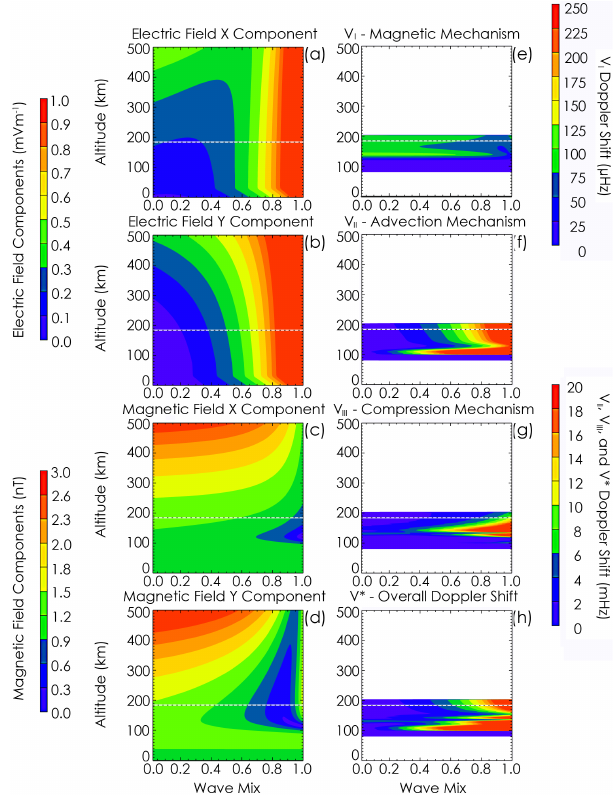
Fig. 8. Electric field, magnetic field and Doppler shift mechanism results for the ULF wave event on 16 April 1998 between 09:45UT– 10:45UT as a function of altitude and wave mix scaled to make the magnetic field magnitude 1nT on the ground. Panel (a) E x . (b) E y . (c) B x . (d) B y . (e) V I . (f) V II . (g) V III . (h) V ∗ .